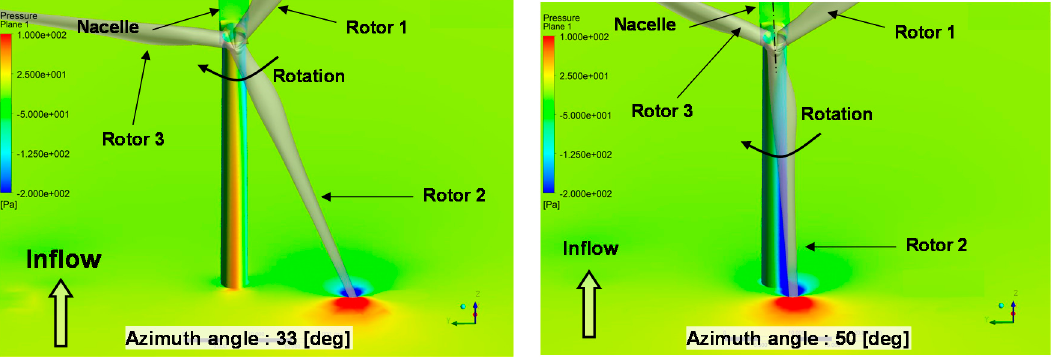
Figure 8. Pressure distribution due to blade-tower interaction.